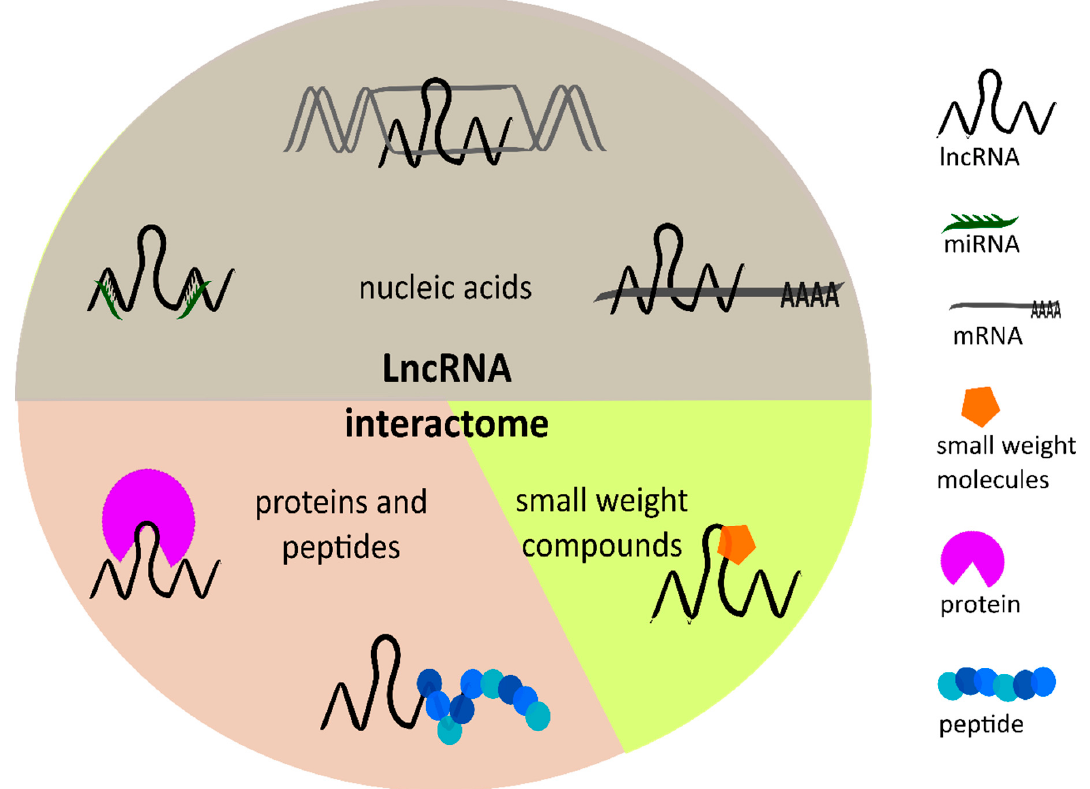
Figure 2. Overview of the lncRNA interactome. Possible interactions partners of lncRNAs are nucleic acids such as DNA, messenger RNA (mRNA), and miRNA, as well as proteins and peptides and small-weight compounds. Due to their broad variety of interaction partners, lncRNAs can further influence multiple cellular processes.